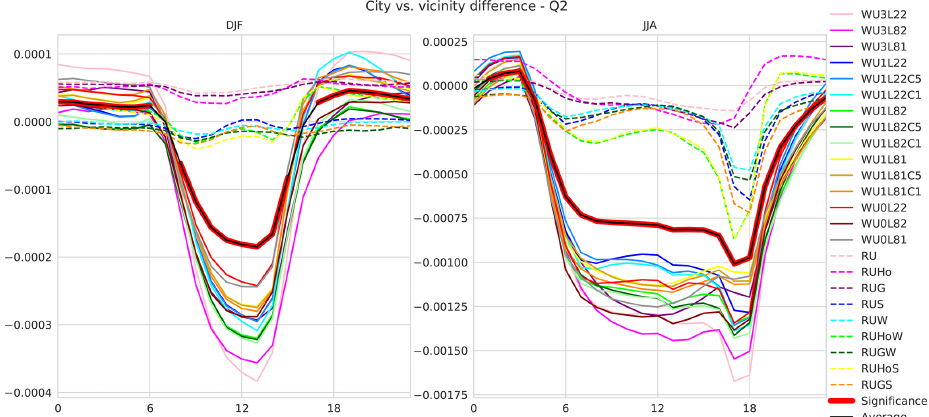
Figure 13. Diurnal cycle of city–vicinity differences for specific humidity (in kgkg − 1 ).